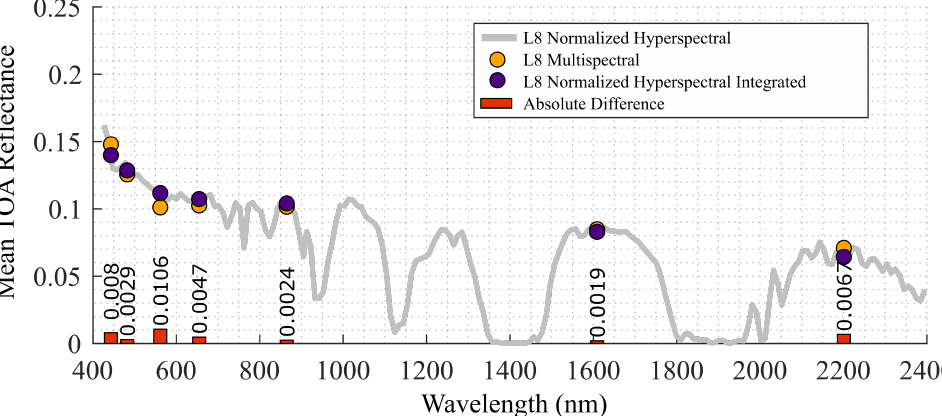
Figure 9. Showing L8 normalized hyperspectral TOA reflectance (grey curve), L8 multispectral TOA reflectance (orange circle), L8 normalized hyperspectral integrated TOA reflectance (purple circle), and absolute difference (red bar): before relative